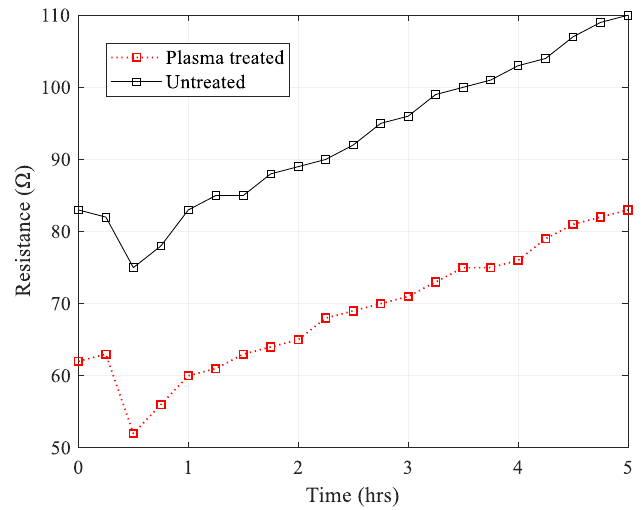
Figure 8. Average resistance of untreated and plasma treated PET fabric samples over 5 hrs.